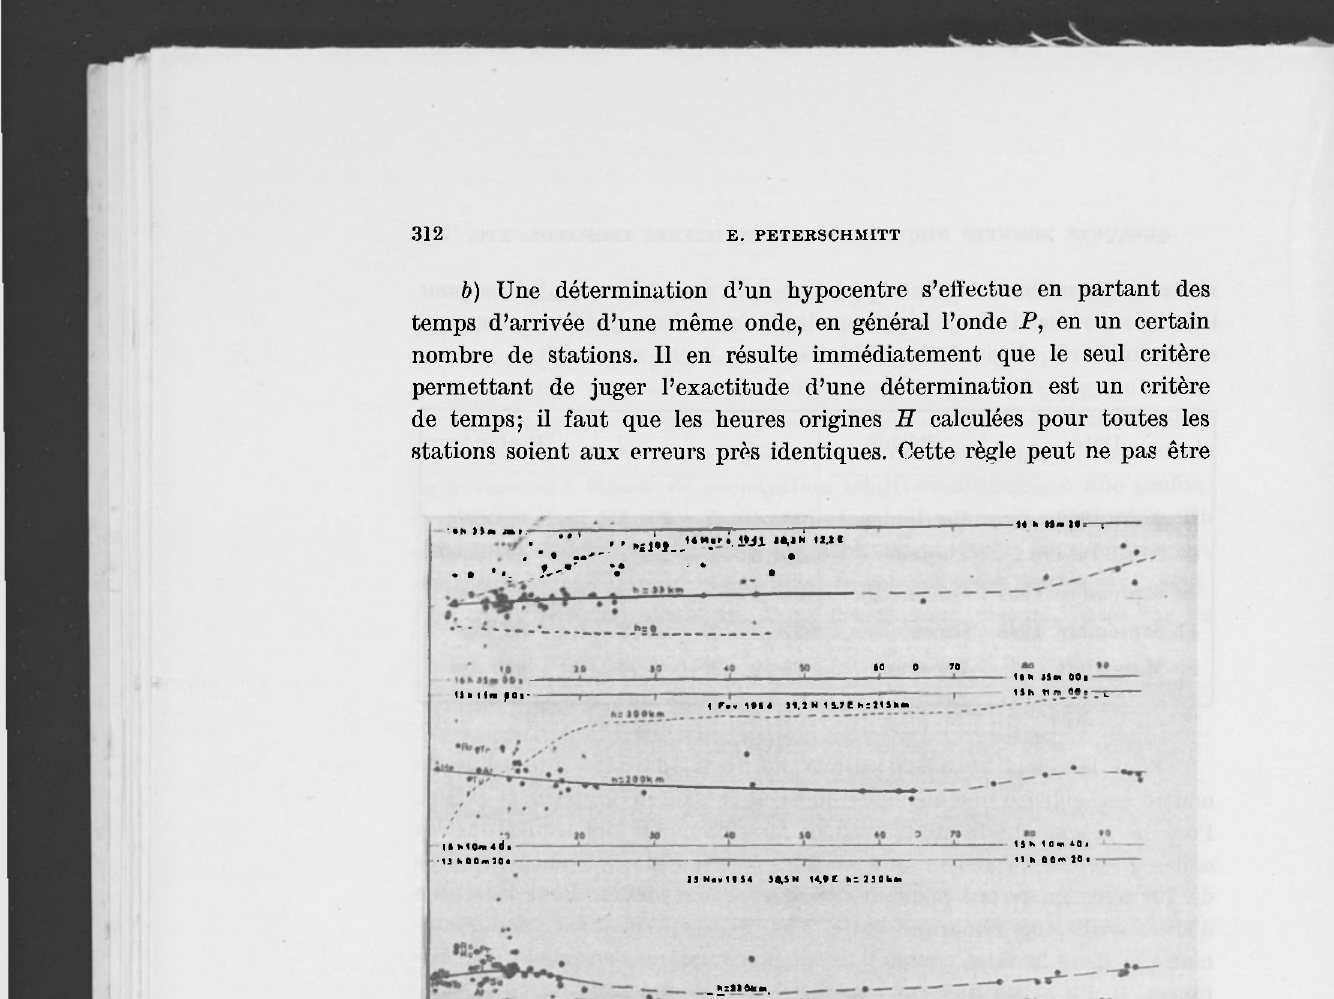
Fig. 2 Heures origines en fonction de la distance épicentrale. Point: onde P; Cercle: onde